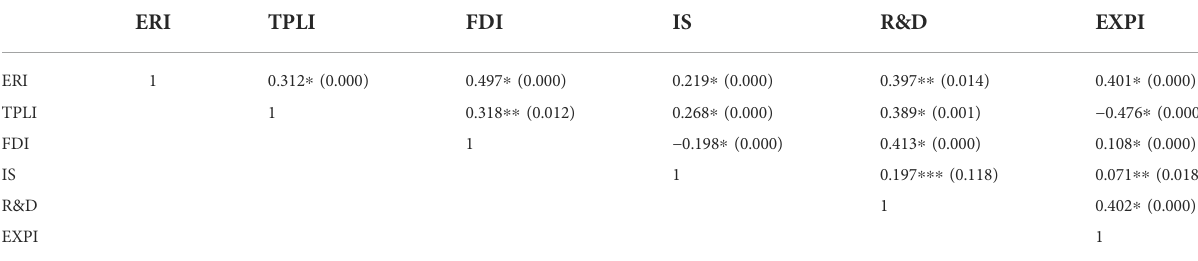
TABLE 3 Pearson correlation analysis.